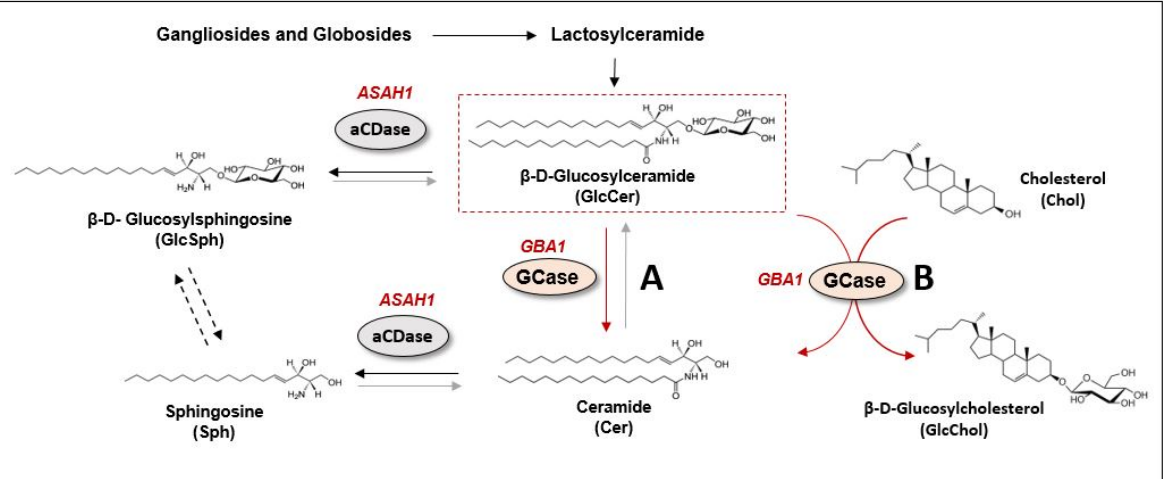
Figure 2. GBA-related lipid metabolism. β -D-Glucosylceramide (GlcCer) is cleaved by glucocerebrosidase enzyme (GCase or GBA, encoded by GBA1 gene) to generate free ceramide (Cer) (A reaction in red). In a healthy condition, there is a fast hydrolysis of GlcCer into Cer, which is then converted to sphingosine (Sph) by acid ceramidase enzyme (aCDase, encoded by ASAH1 gene) (reaction in black). In absence of GBA/GCase activity, GlcCer cannot be converted into Cer and its conversion to β -D- Glucosylsphingosine (GlcSph) by aCDase is favored The direct conversion of GlcSph into Sph is still under debate (reaction in dotted black). GBA/GCase secondary enzymatic activity in the transglycosidation reaction between GlcCer and cholesterol (Chol), producing Cer and glucosylated cholesterol (GlcChol) (B reaction in red). This reaction has been shown to act in both directions, the inverse reaction being more physiologically relevant.